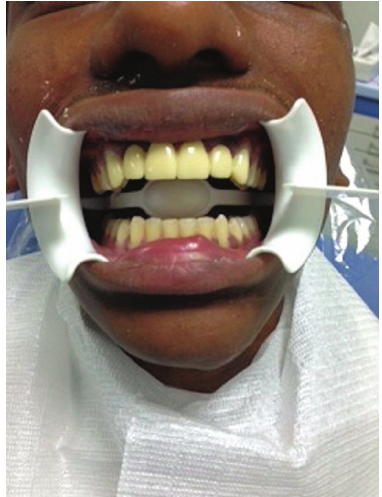
Figure 2: Posterior occlusal interference on mandibular lateral movement.